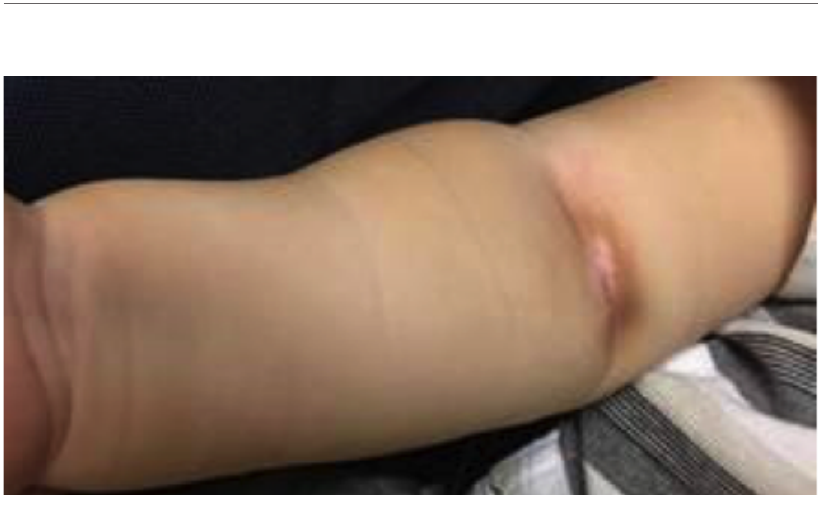
Figure 2. Patient's right arm at follow-up performed six months